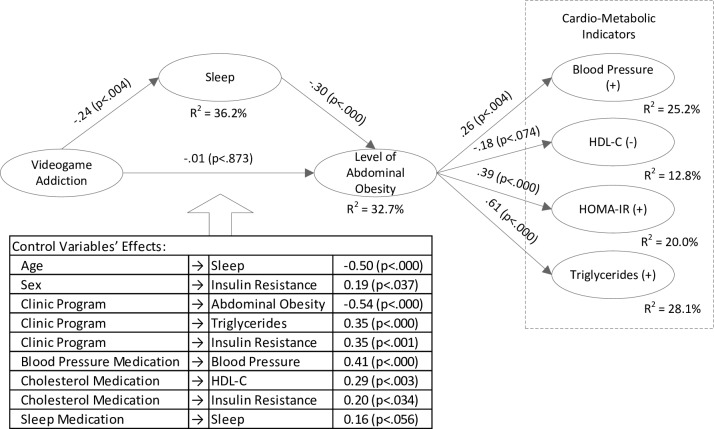
Structural Model.